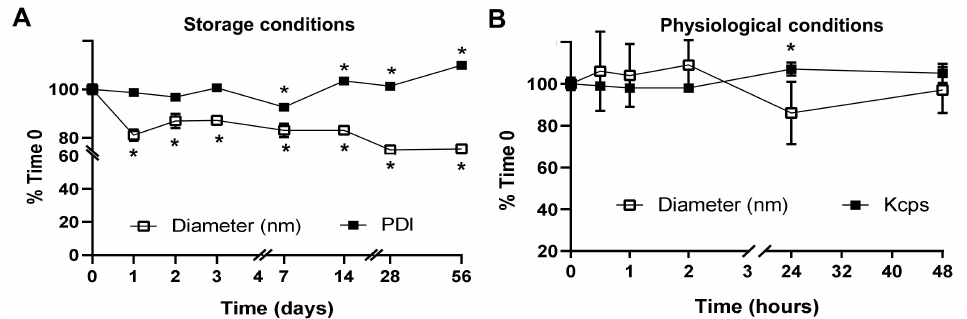
Figure 2. Stability of anti-ICAM PLGA NPs encapsulating HAse. Lactel II–F68 PLGA NPs encapsu- lating HAse and coated with anti-ICAM were incubated for the indicated time periods ( A ) at 4 ◦ C in phosphate buffer saline (PBS) to mimic storage conditions or ( B ) at 37 ◦ C in 50% fetal bovine serum to mimic physiological conditions. Samples were analyzed by dynamic light scattering (DLS) to determine their average hydrodynamic diameter, polydispersity index (PDI), and associated kilo counts per second (kcps) compared to the original formulation (Time 0). Data are the mean ± SEM (non-visible error bars are hidden by the data symbol). Statistics were assessed by Student’s t -test ( p < 0.05). * Compares each time point to Time 0